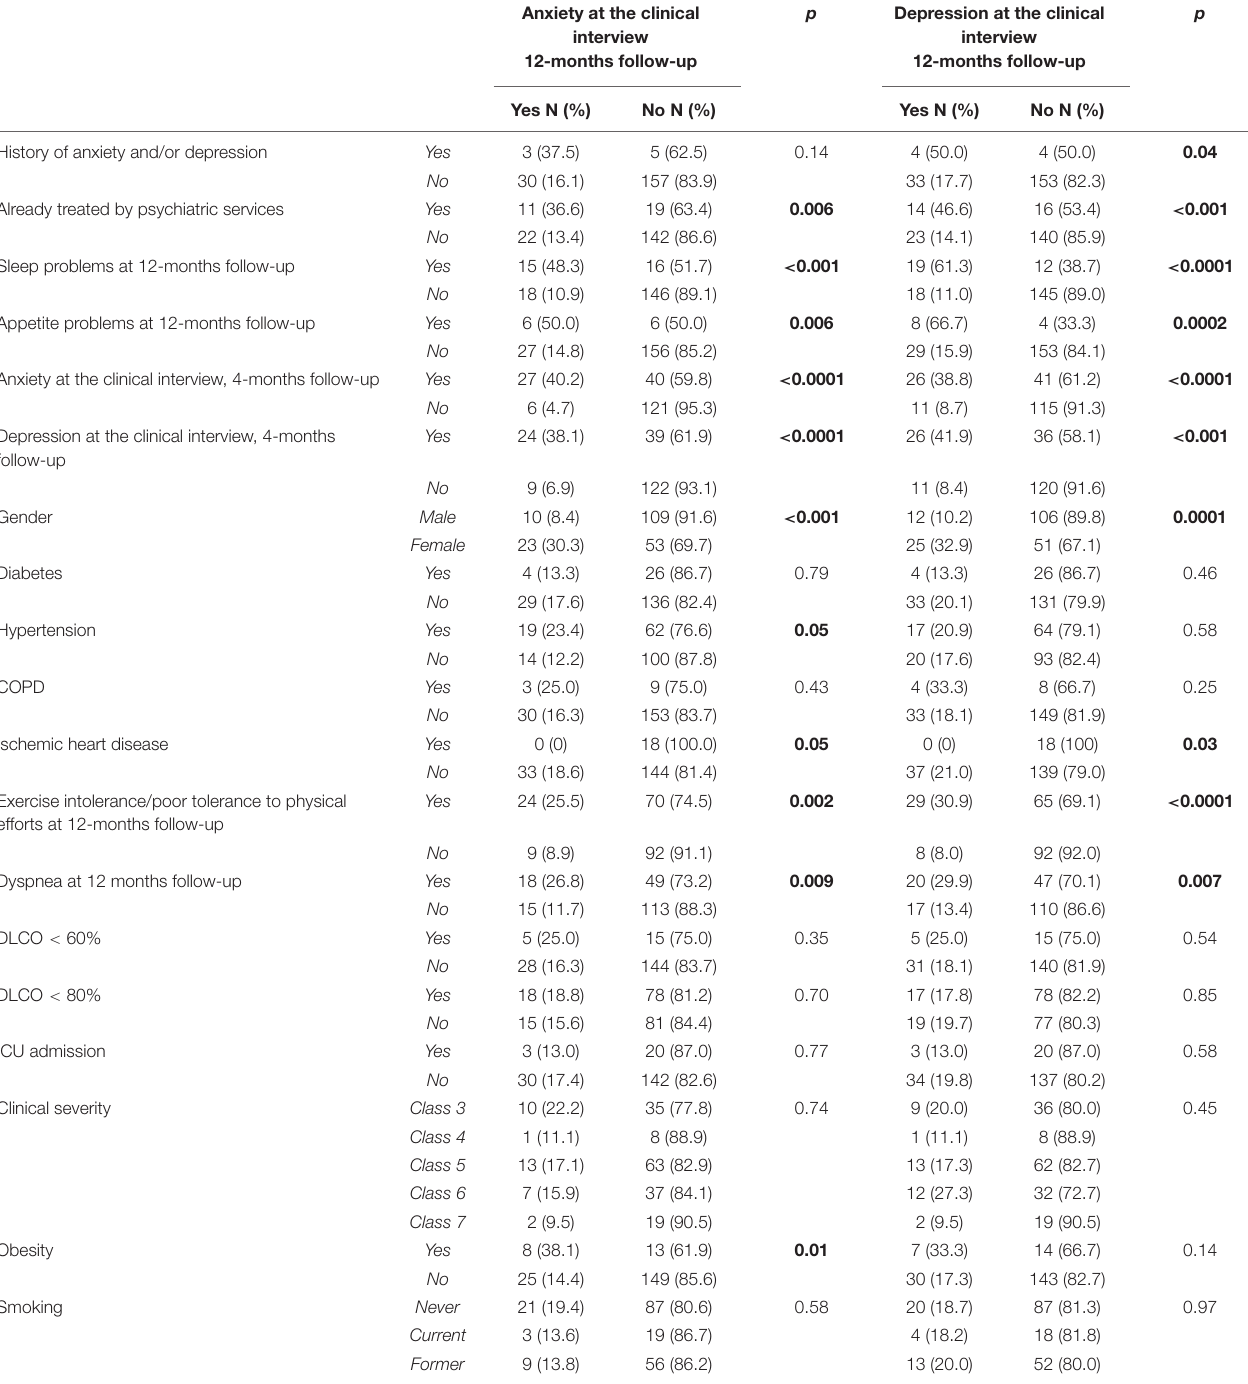
TABLE 2 | Anxiety and depression as assessed with the psychiatric interview at the 12-month follow-up: association with psychiatric, somatic, and clinical variables (chi-squared test).